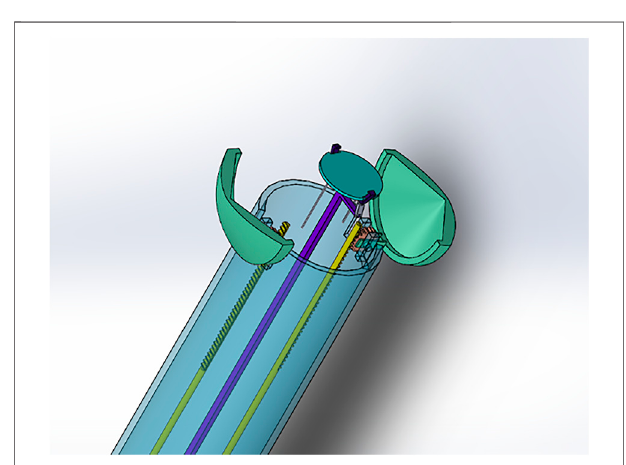
FIGURE2| Clawdesign(openpositionwithplateholderprotruding).For secure robotically-enabled transplantation of cardiac patches using minimally invasive heart